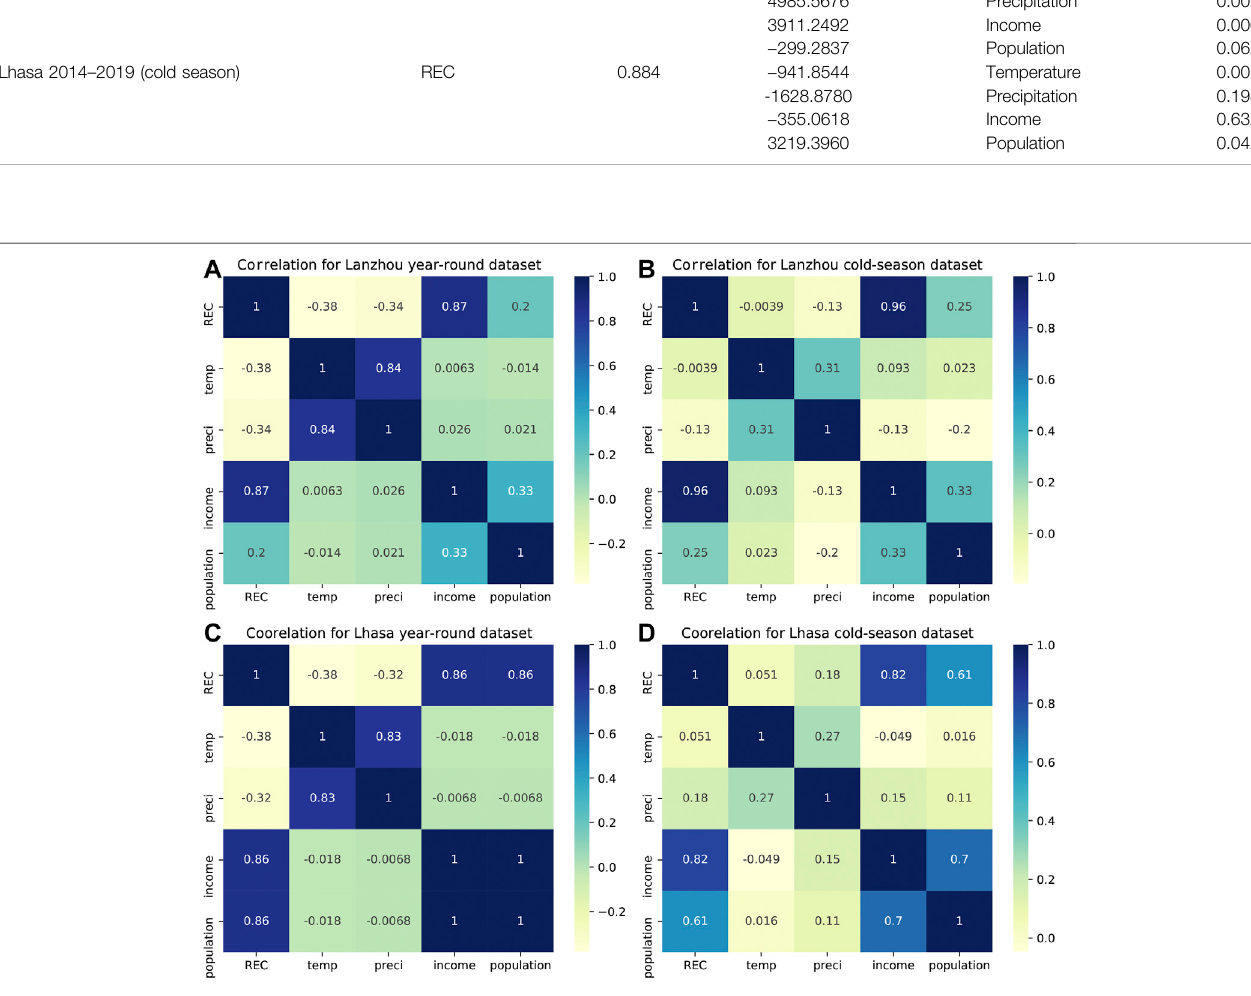
Frontiers in Earth Science |